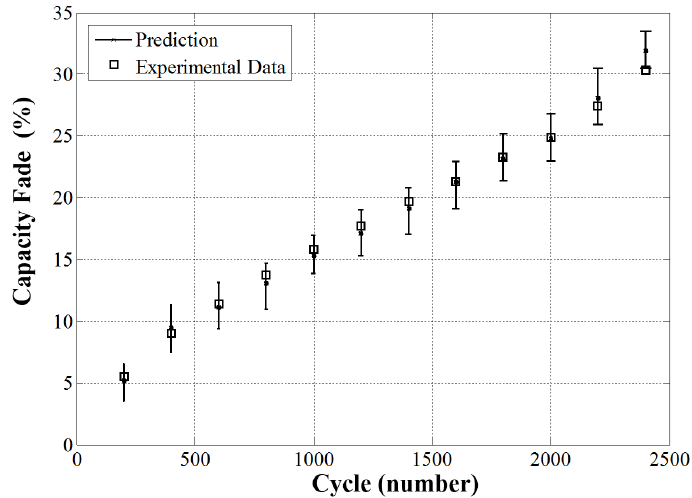
Figure 10. Capacity-fade estimation using the metamodel over the